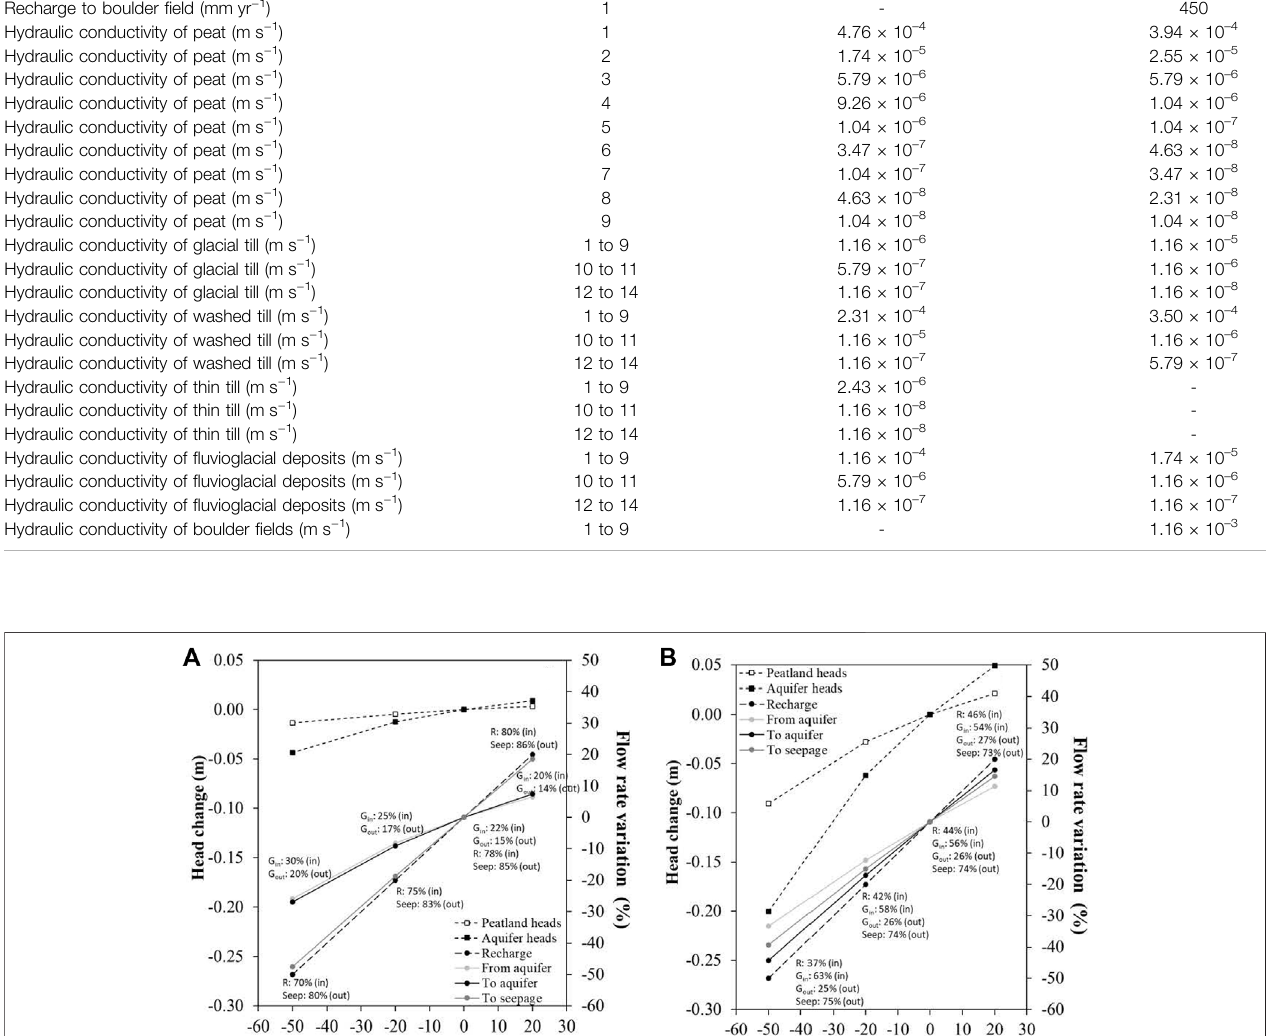
Frontiers in Earth Science |